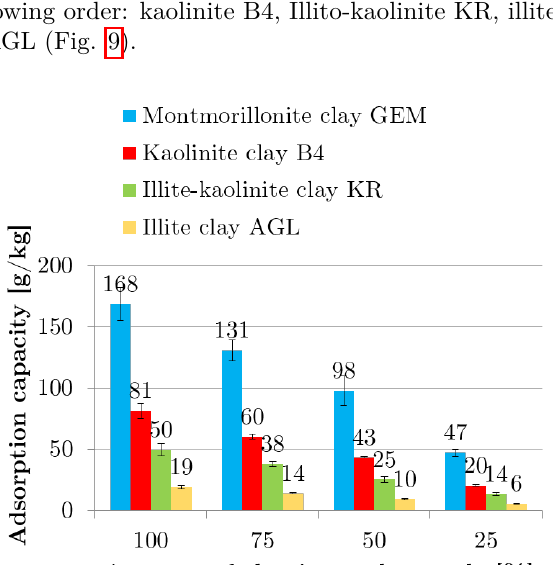
Figure 9. Obtained results of adsorption